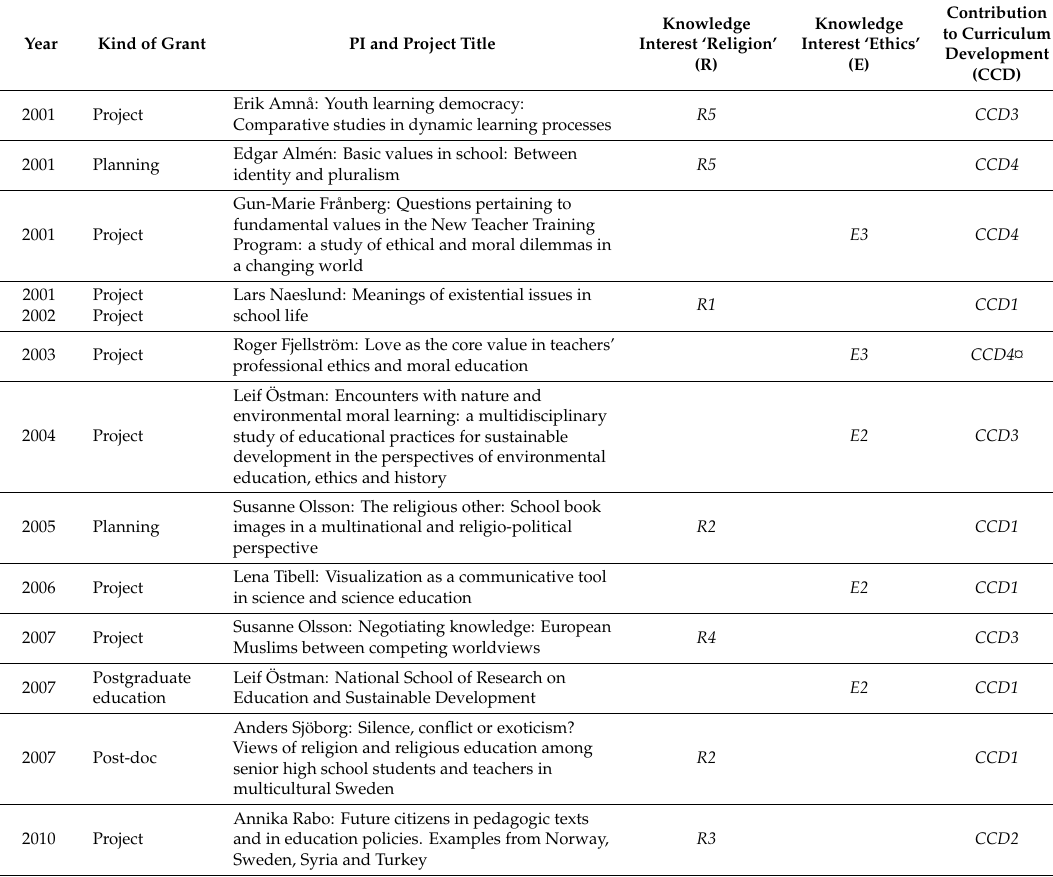
Table A1. Current projects and the presented categories concerning knowledge interest in ‘religion’ (R1–5) and ‘ethics’ (E1–3) and possible contribution to curriculum development (CCD1–4)